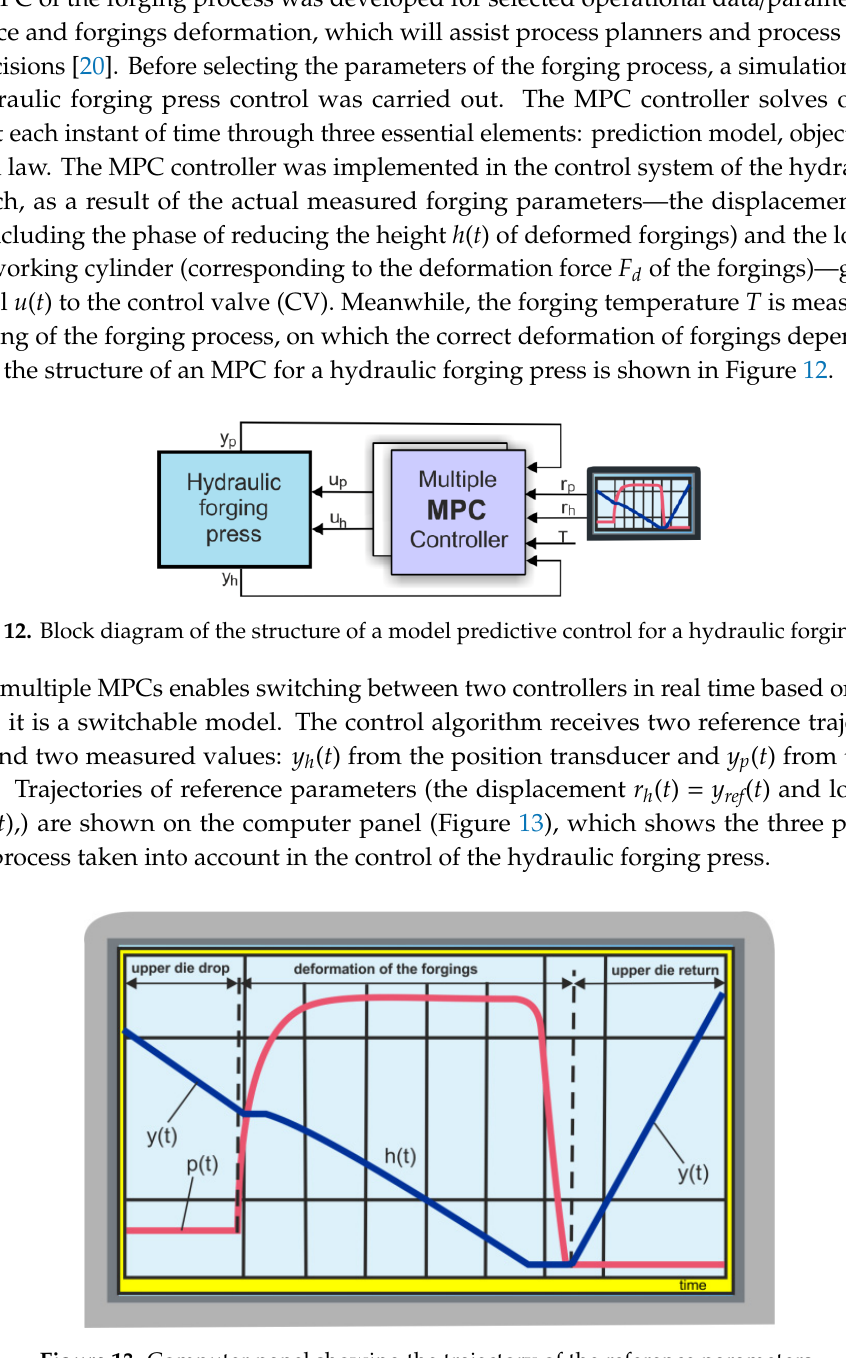
Figure 13. Computer panel showing the trajectory of the reference parameters.